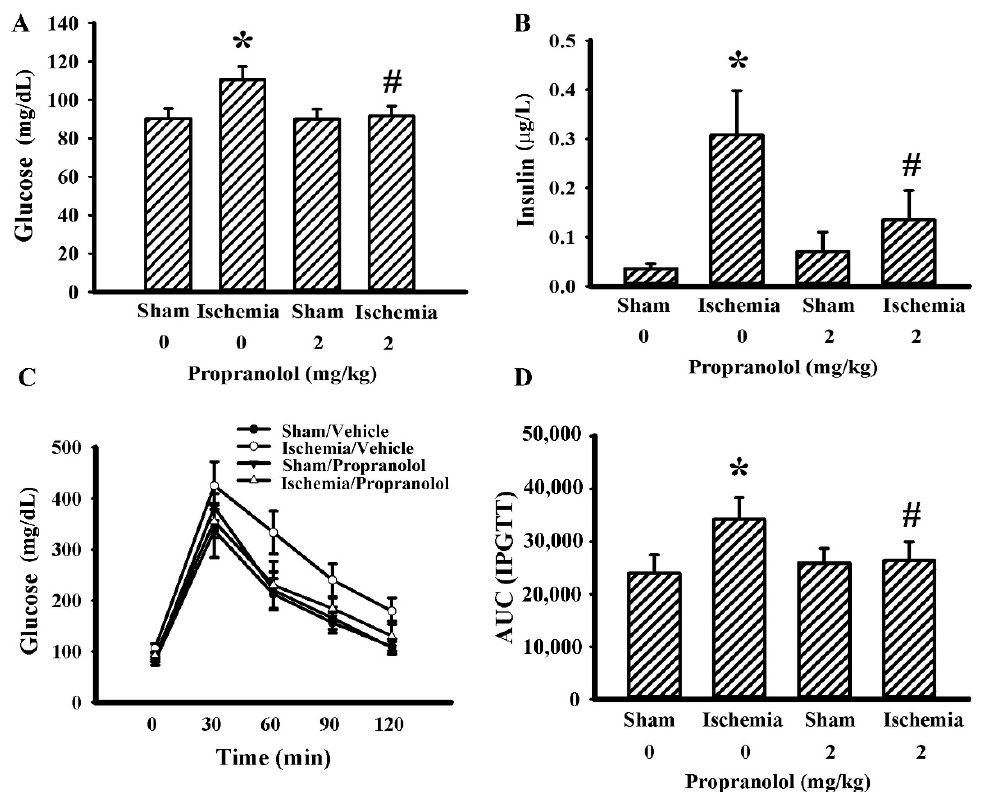
Figure 5. Propranolol alleviated postischemic hyperglycemia. Rats receiving a normal saline vehicle or a propranolol (2 mg/kg) intraperitoneal injection were subjected to sham and permanent cerebral ischemia for 24 h. The blood samples were collected from 8 h fasting rats and subjected to glucose ( A ) and insulin ( B ) measurement. The 8 h fasting rats were intraperitoneally injected with a glucose solution (2 g/kg). Blood samples were collected from the tail veins at the indicated times after treatments and the levels of glucose were measured ( C ). The area under the curve (AUC) of the glucose time curves was calculated ( D ). * p < 0.05 vs. sham/saline group and # p < 0.05 vs. ischemia/saline group, n = 6.